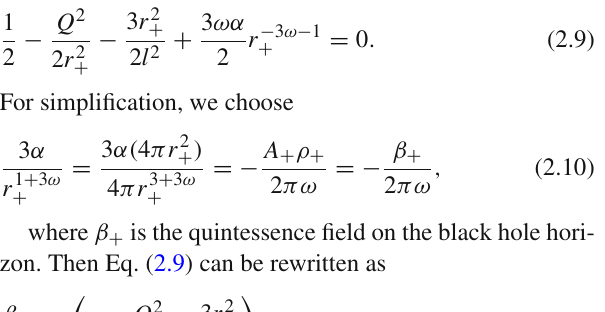
Fig. 3 r A , C − l 2 curves with Q = 1, ω = − 1 / 2. The red solid line stands for β + = 0 . 0001, the green solid line for β + = 0 . 0005, and the black solid line for β + = 0 . 0008